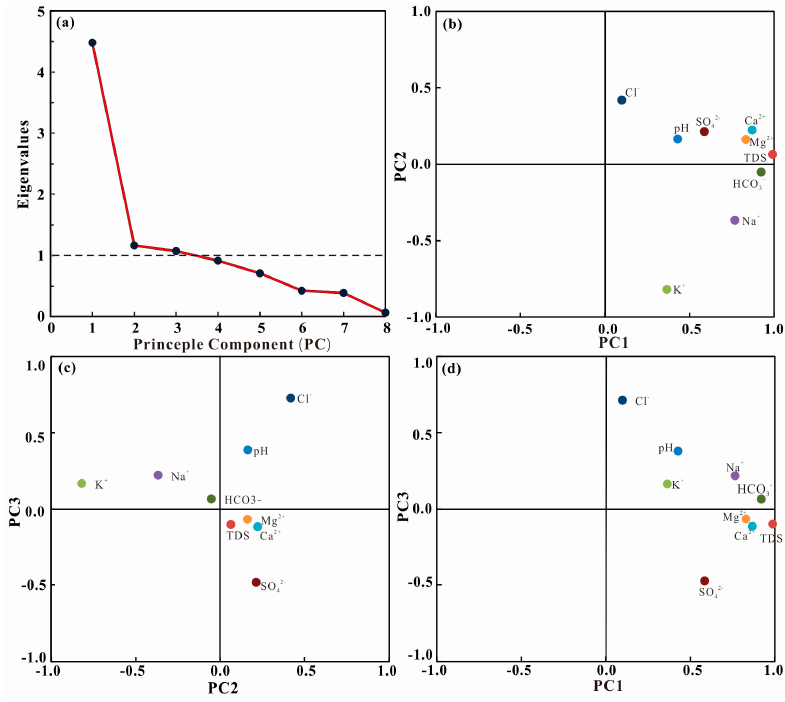
Figure 9. ( a ) Scree plot; Factor loadings for ( b ) PC1 and PC2; ( c ) PC2 and PC3; ( d ) PC1 and PC3.